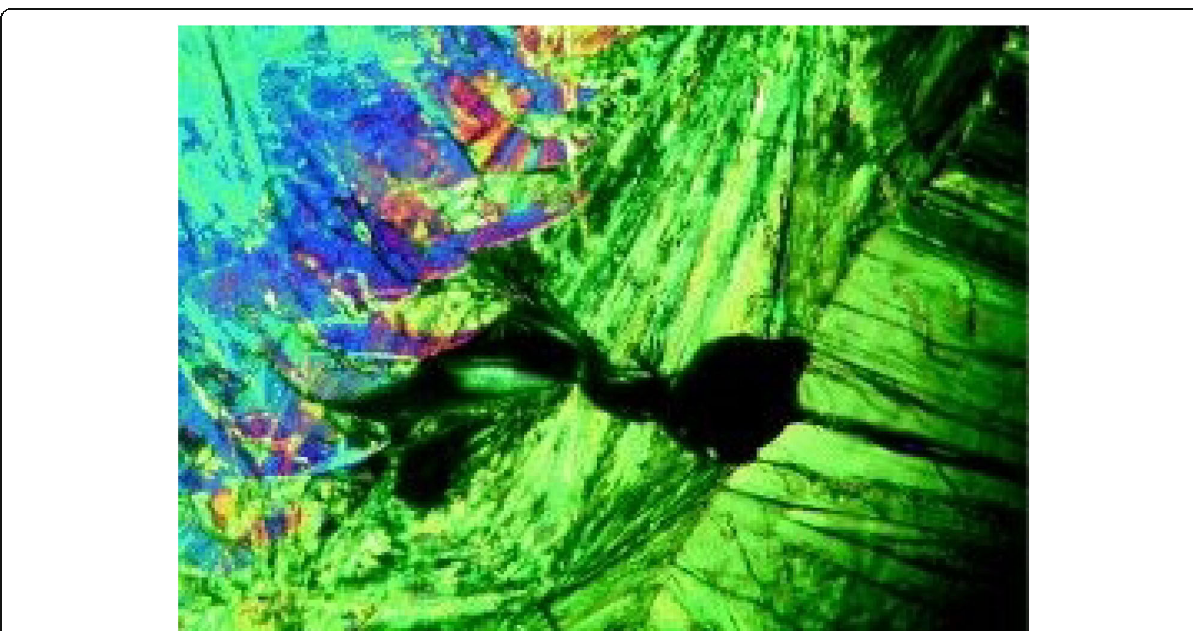
Fig. 2 Birefringence pattern observed in Salicylic acid: Benzamide cocrystals. Reprinted from Zhou et al. 2016 with permission from the